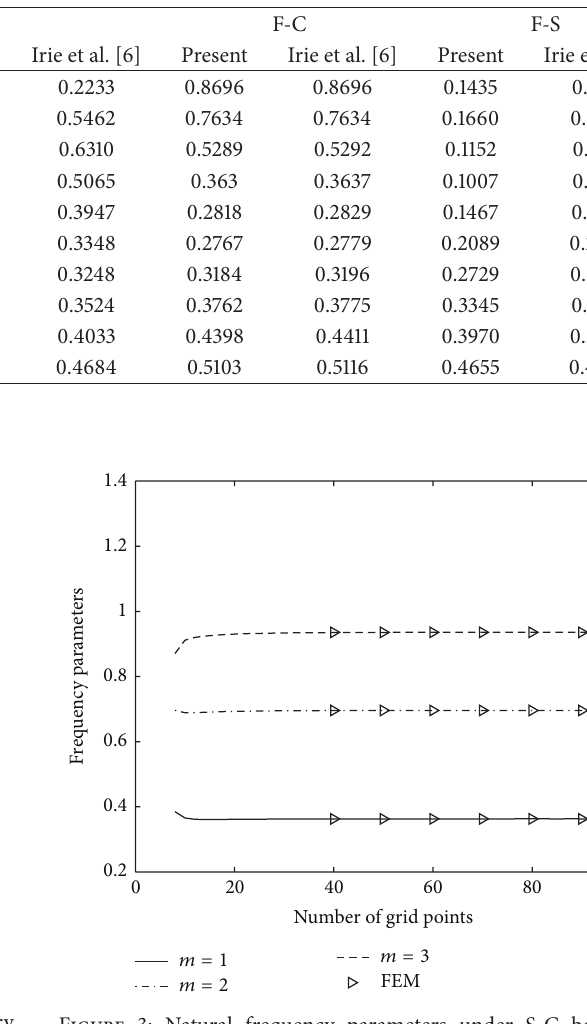
Figure 3: Natural frequency parameters under S-C boundary conditions ( 𝑛 = 3 , 𝑚 = 1, 2,3